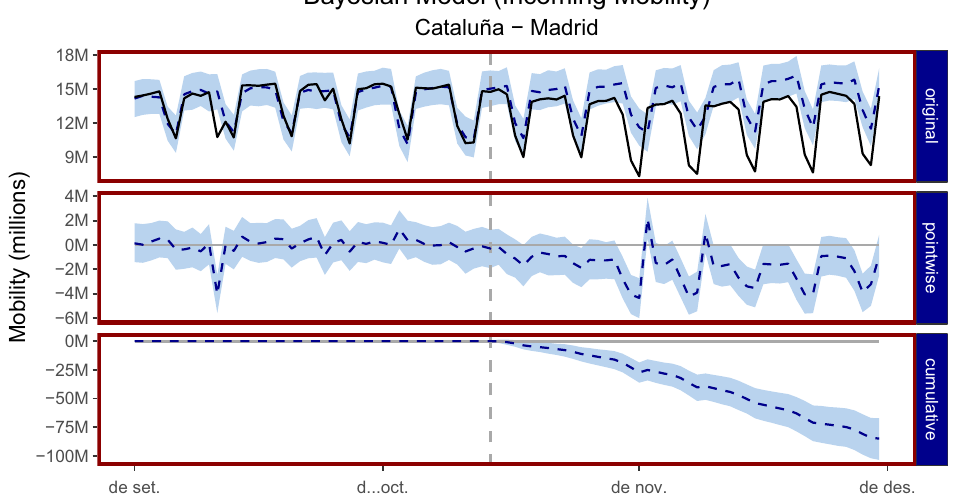
de set. Figure 7. Bayesian structural time-series model: the original panel corresponds to the actual data and a counter-factual prediction for the post-treatment period. The pointwise panel shows the pointwise causal effect and it is the difference between the observed data and the counterfactual predictions. The cumulative panel shows the cumulative effect of the policy impact. Data before the dotted vertical line correspond to the observed data and a pre-policy predictive model, the data after the vertical dotted line corresponds to the observed data and a post-policy predictive model, that is, a synthetic counter-factual showing what the mobility in Cataluña may have looked like had the policy not been implemented. All figures are in raw data format, that is, 15M corresponds to 15 million trips for that day. On the x-axis, de set refers to Setembre (September) and de des refers to desembre (December).